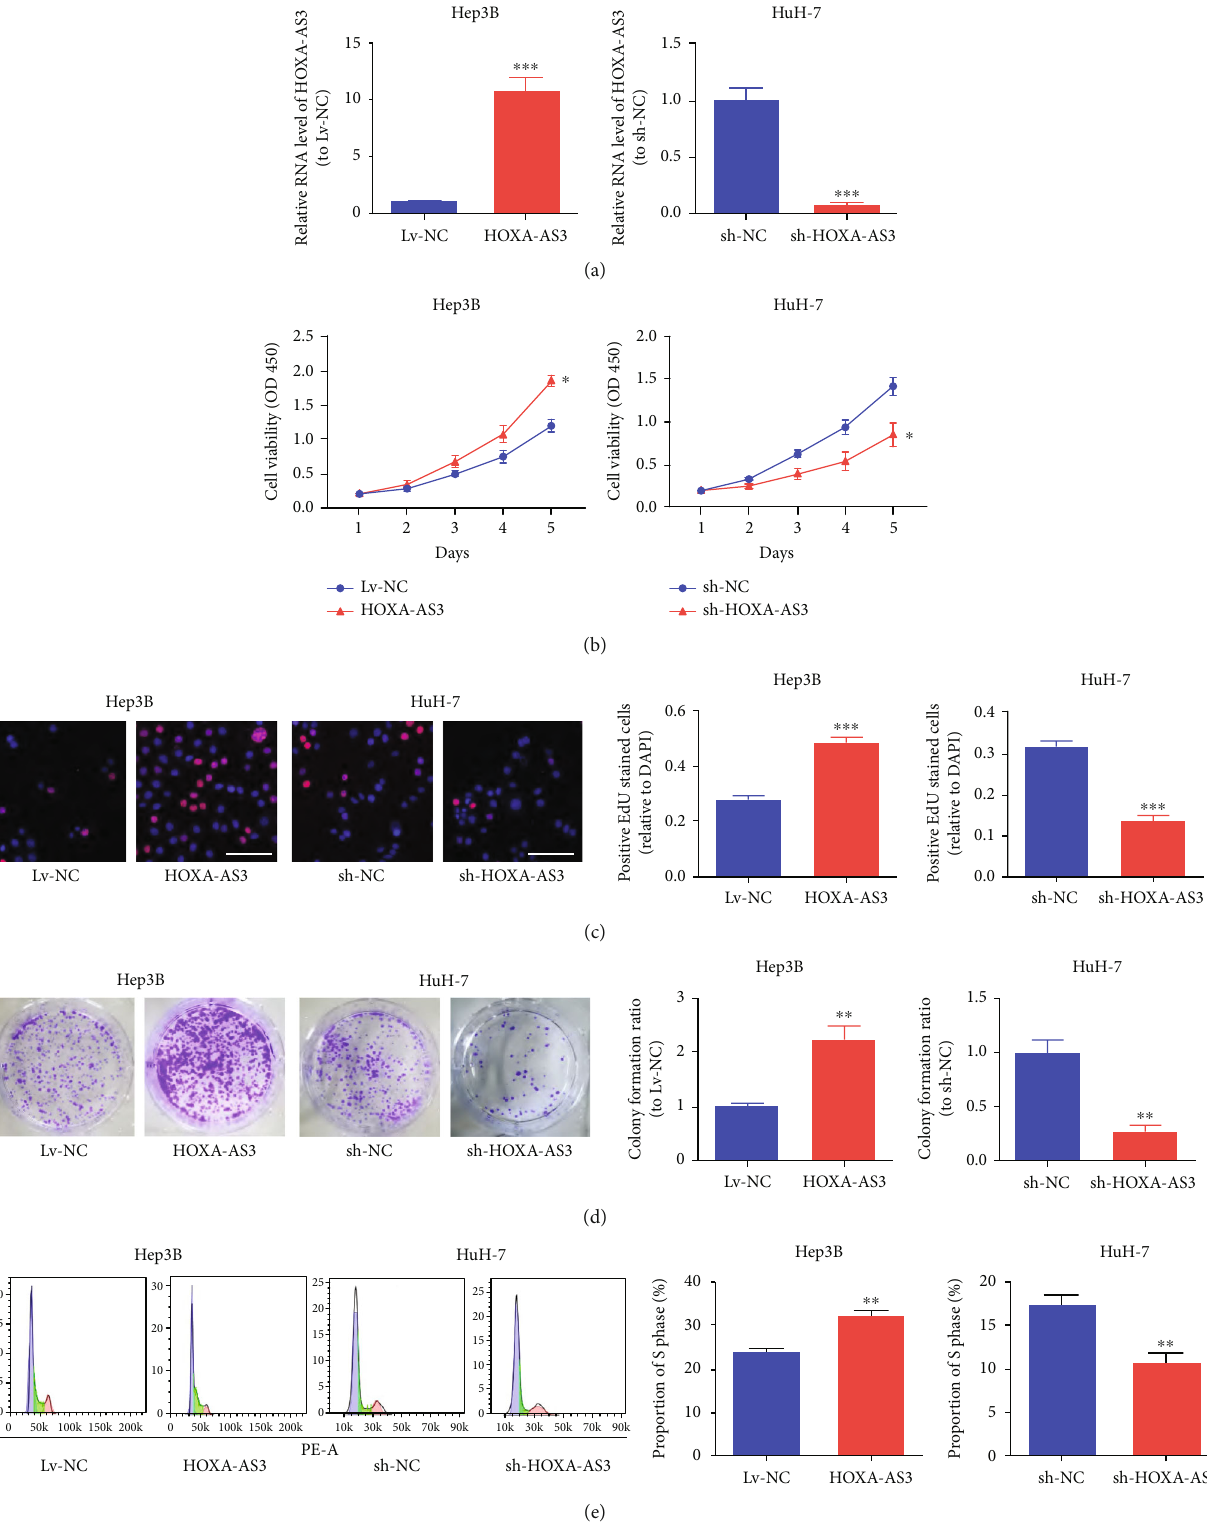
Figure 2: HOXA-AS3 promotes HCC cell proliferation and cell cycle. (a) HOXA-AS3 expression in transfected Hep3B and HuH-7 cells. (b) CCK-8 assay, (c) EdU ( bar = 100 μ m), and (d) colony formation assays to determine the e ff ects of HOXA-AS3 on HCC cell proliferation. (e) Cell cycle of transfected Hep3B and HuH-7 cells. Data are reported as the mean ± SD of three separate experiments; ∗ P < 0 : 05 , ∗∗ P < 0 : 01 , and ∗∗∗ P < 0 : 001